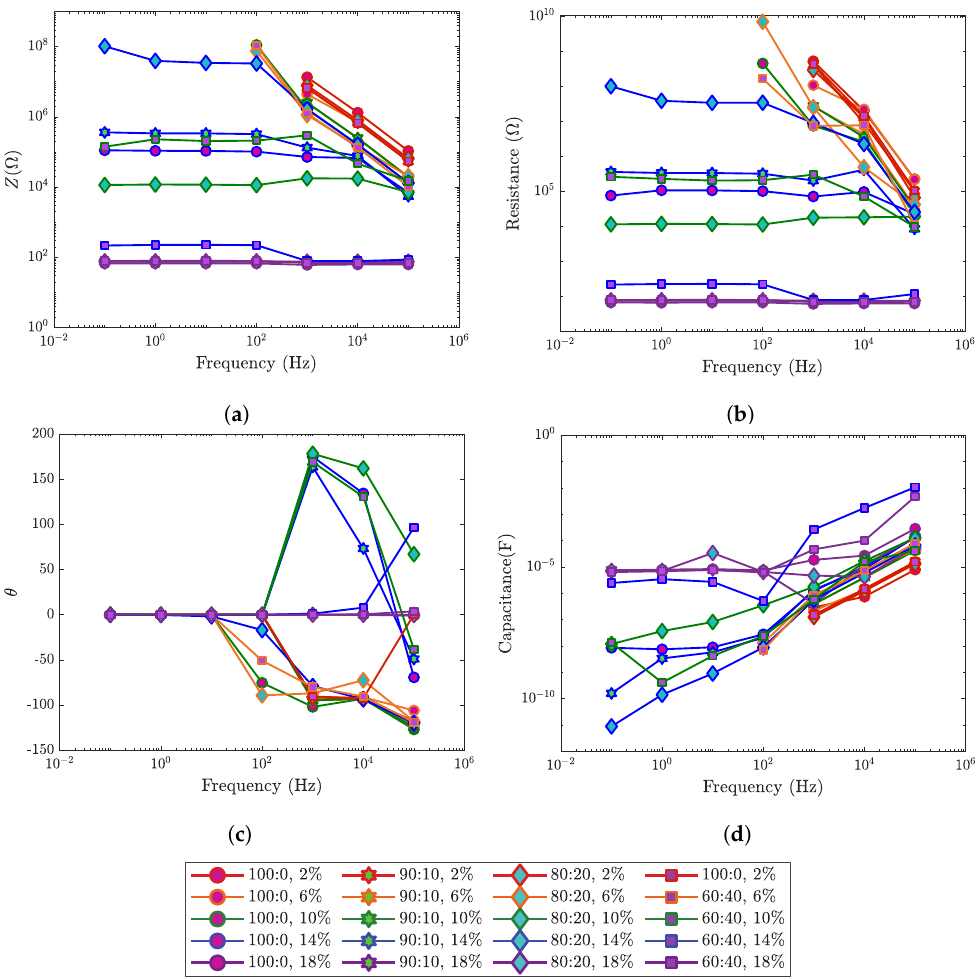
Figure A3. Four point impedance testing of PHBV:PLA blends at increasing CB nanofiller percentages: ( a ) impedance, ( b ) resistance, ( c ) angle, and ( d ) capacitance versus